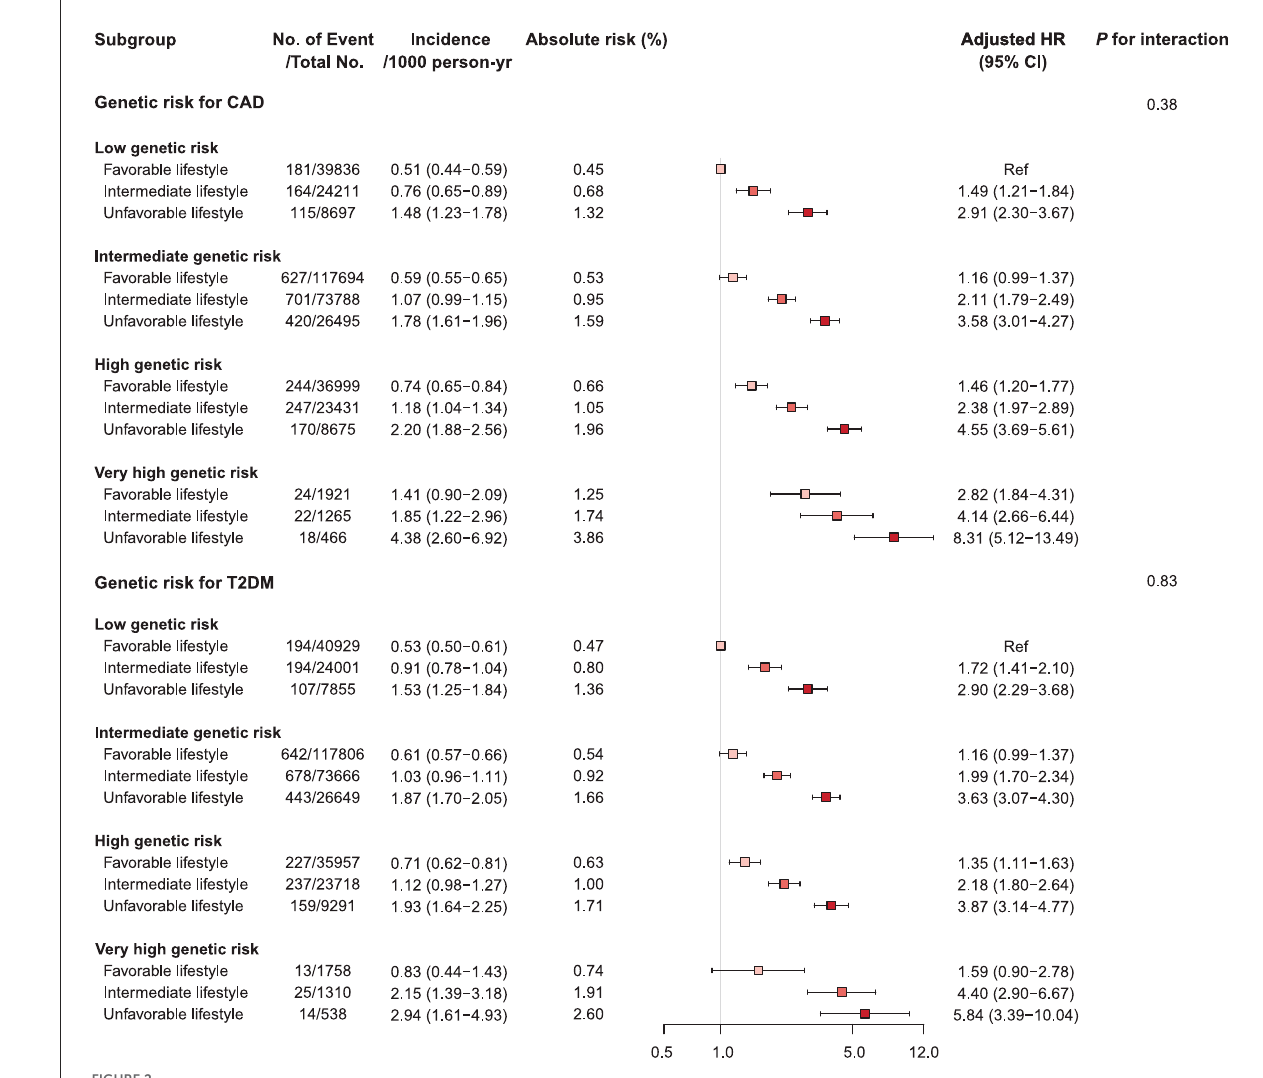
FIGURE2 Forest plot of cardiovascular mortality according to genetic risk and lifestyle risk. Cox regression model was adjusted for age, sex, genotyping array, and first ten principal components of ancestry. p -values are for testing the interaction between each genetic risk category and lifestyle category. CAD, coronary artery disease; CI, confidence interval; HR, hazard ratio; T2DM, type 2 diabetes